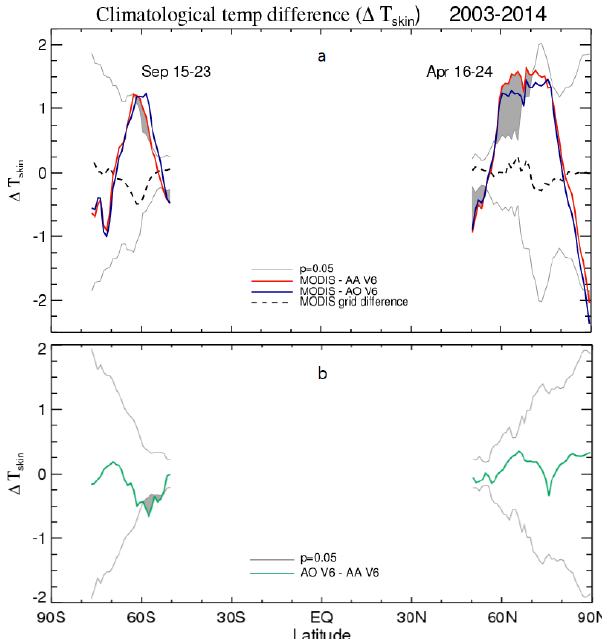
Figure A1. The difference values (a) between T skin (MODIS) and T skin (AA_V6), and (b) T skin (AA_V6) and T skin (AO_V6) over a possibly frozen region; shown in Fig. 7. The 5% significance level is presented as grey solid lines, and the shaded areas are statistically significant at the 0.05